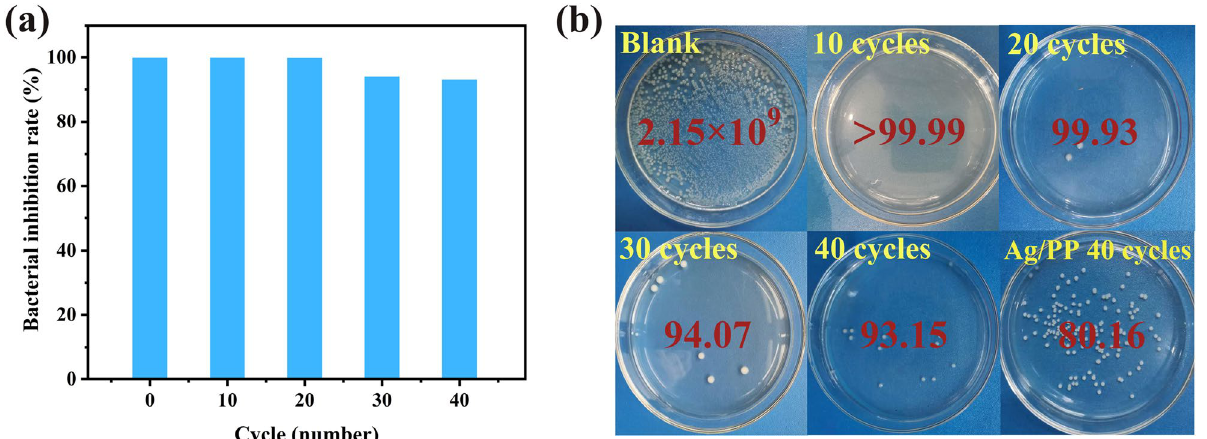
Figure 7. ( a ) Antibacterial rate against E. coli . ( b ) Digital camera pictures of Ag/PVA/PP fabric after being washed for 10, 20, 30, 40 cycles, and 40 cycles of the Ag/PP fabric obtained under the silver ammonia concentration of 30 mM is also given for a comparison.